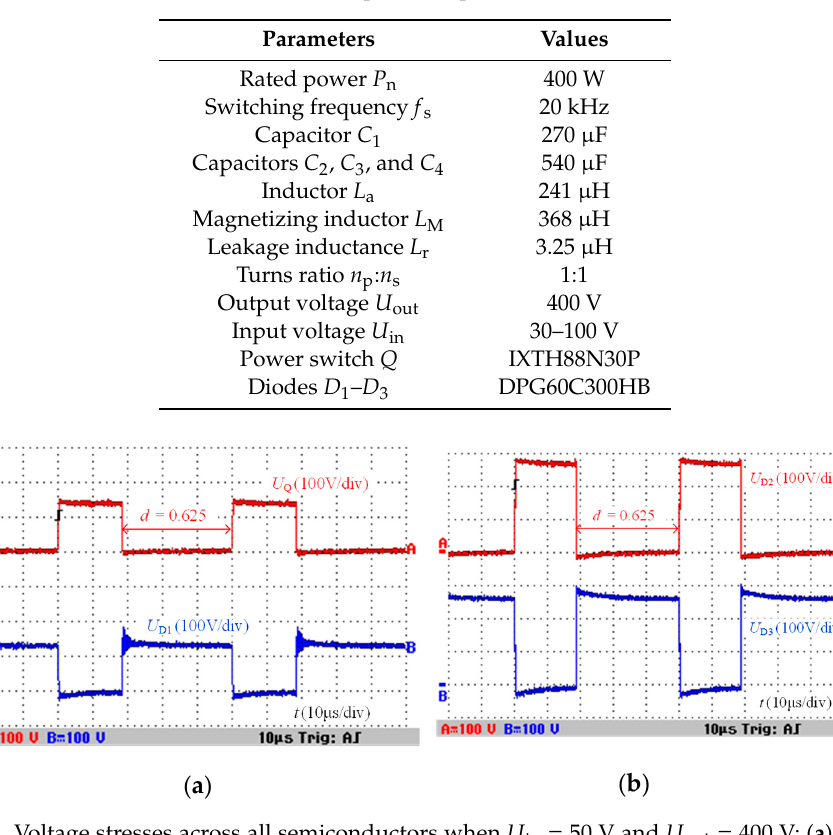
Figure 7. Voltage stresses across all semiconductors when U in = 50 V and U out = 400 V: ( a ) Voltage stresses across Q and D 1 ; ( b ) voltage stresses across D 2 and D 3 .